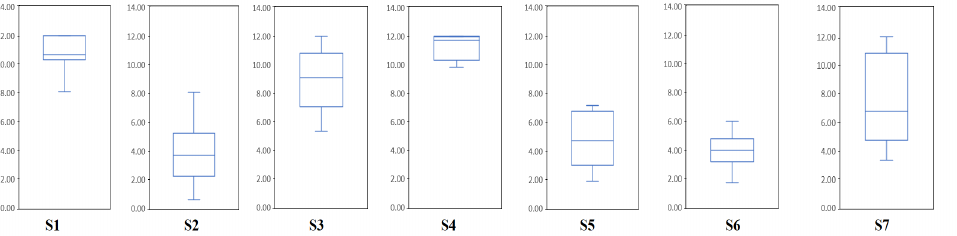
Figure 6. Boxplots represent the ITRs of different sessions for each subject. Each box plot includes 12 sessions of data. The upper and lower lines represent the maximum and minimum ITRs, respec- tively. The lines in the boxplot represent the median